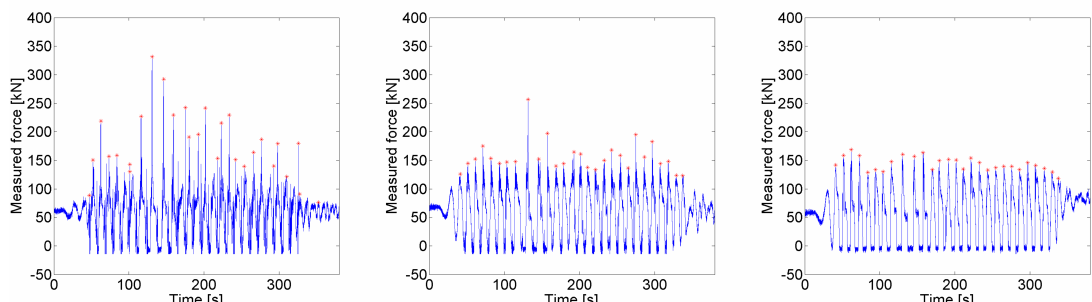
Figure 14. This figure is reprinted with permission from reference [24]. In a physical wave tank experiment, the line force of a WEC was studied when different levels of frictional damping were applied. The incident wave had a height of 5.7 m and an embedded focused extreme wave hit the WEC at t = 134 s. Three levels of friction was applied: 18 kN ( left ), 59 kN ( middle ), and 83 kN ( right ). The force in the endstop hits decrease with increased